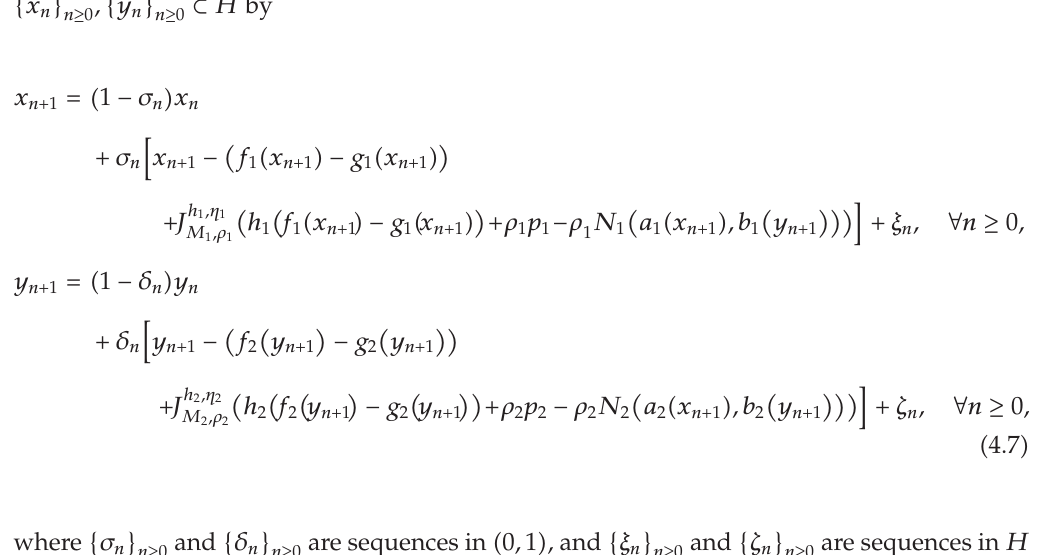
Algorithm 4.3 (cid:4) The implicit Mann iteration method with errors (cid:5) . For any x 0 , y 0 ∈ H , compute } ⊂ H by { x , { y n } n n ≥ 0 n ≥ 0